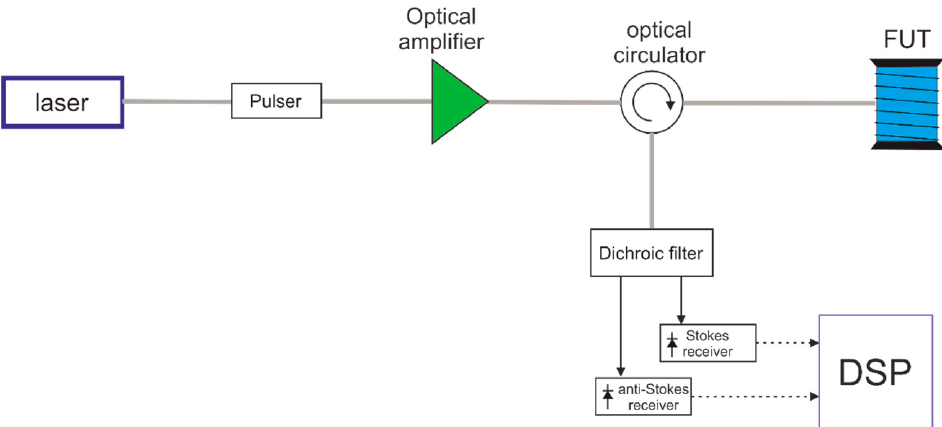
Figure 2. Schematic diagram of a Raman ratio distributed temperature sensor.